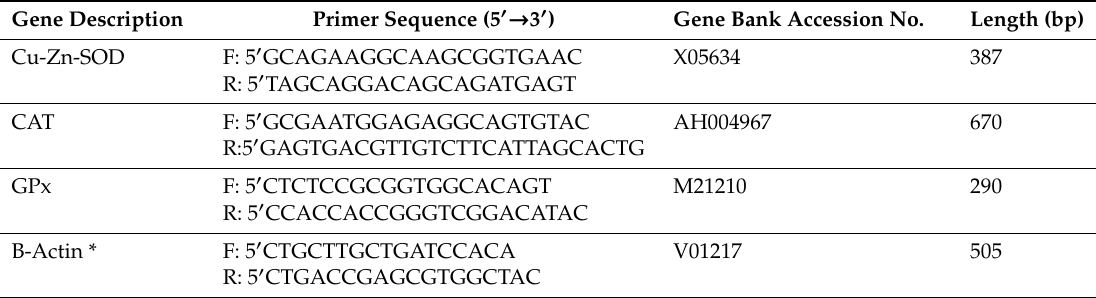
Table 1. Primer sequences used for the analysis of gene expression.